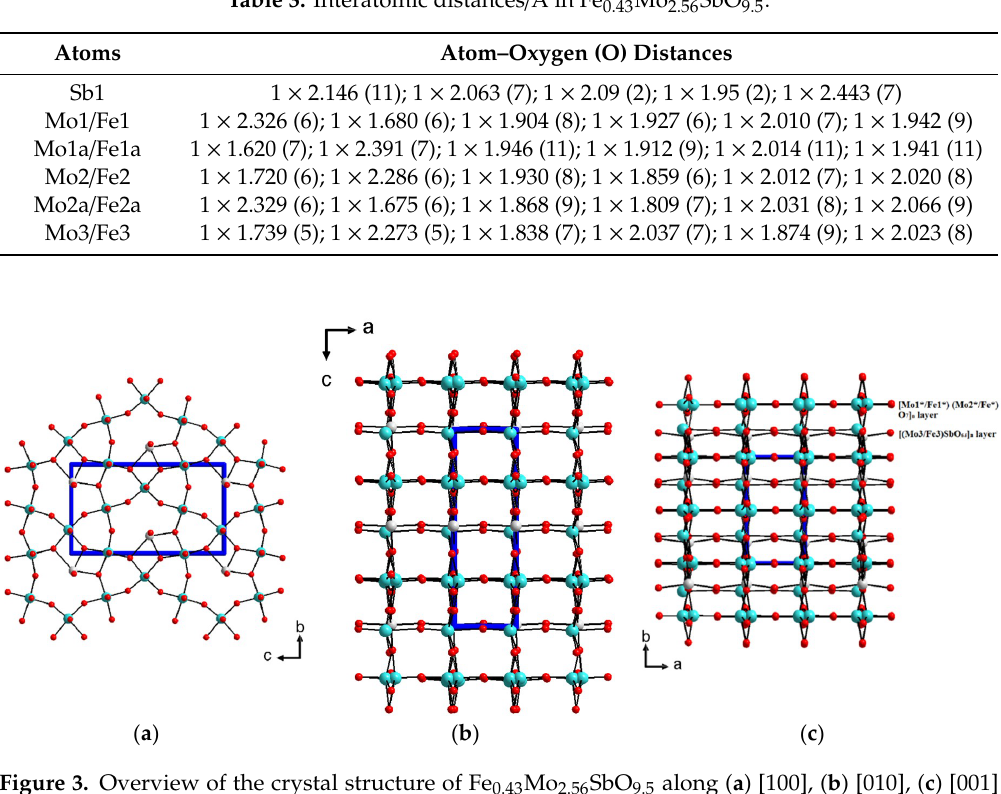
Figure 2. ( a ) The [SbO 3.5 ] n chains and the [(Mo3 / Fe3)O 5 ] n chains form together [(Mo3 / Fe3)SbO 6.5 ] n chains, ( b ) [(Mo1* / Fe1*)O 5 ] n and [(Mo2* / Fe2*)O 5 ] n chains form layers with the composition [(Mo1* / Fe1*)(Mo2* / Fe2*)O 8 . Table 3. Interatomic distances / Å in Fe 0.43 Mo 2.56 SbO 9.5 .